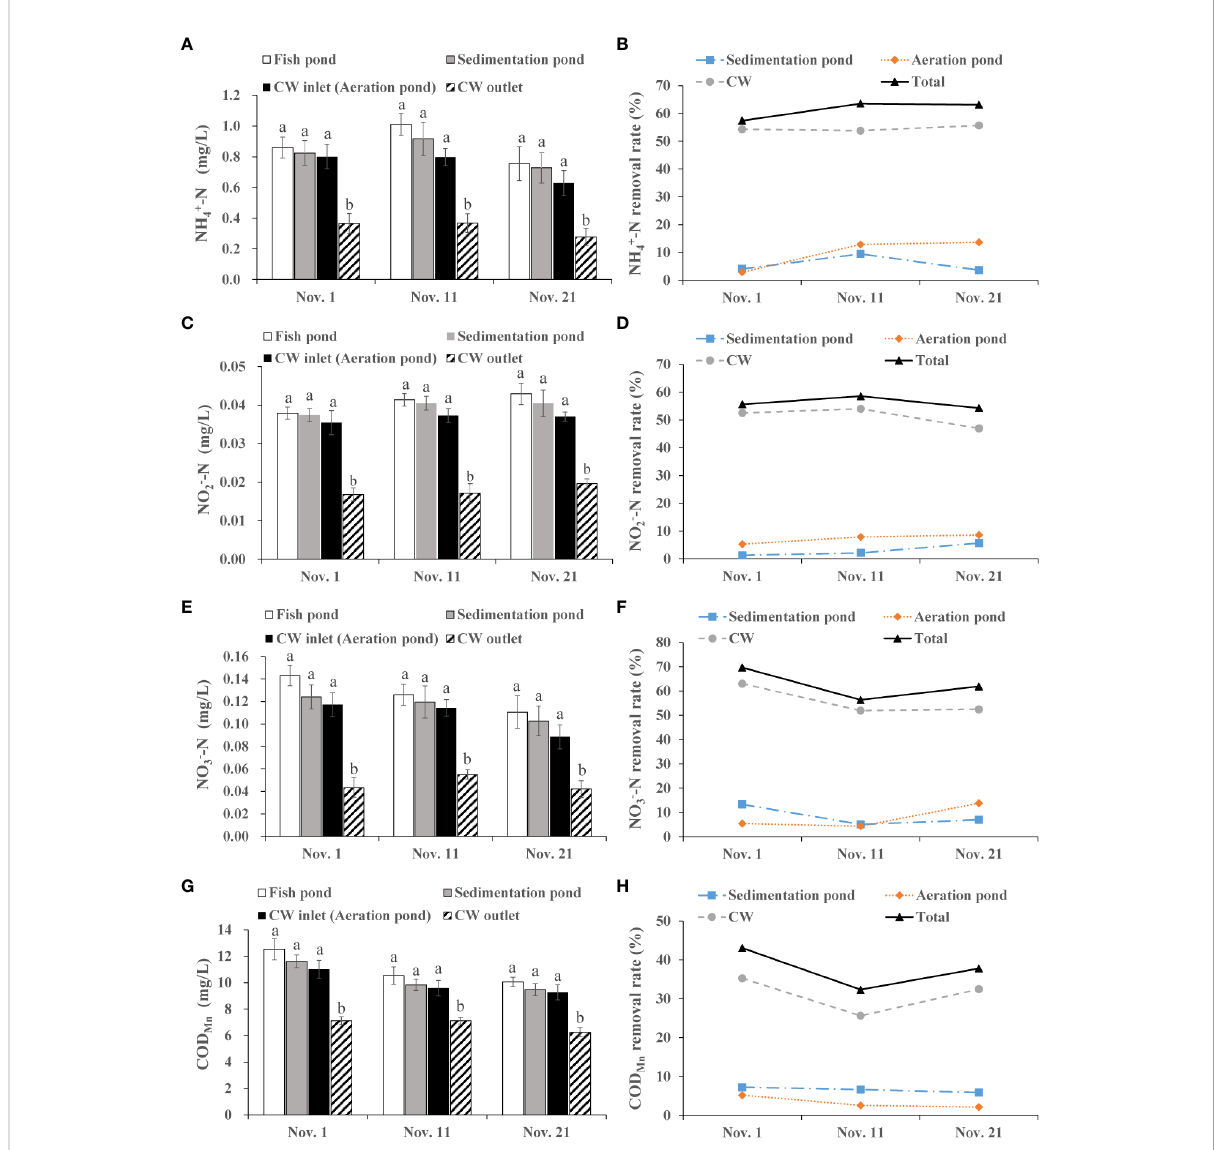
FIGURE 4 Removal ef fi ciency of integrated CW system on NH 4+ -N, NO 3- N, NO 2- -N and COD Mn during the ef fl uents discharge period. (A) NH 4+ -N value in the fi sh pond, sedimentation pond, CW inlet (aeration pond) and CW outlet. (B) NH 4+ -N removal rate of the sedimentation pond, aeration pond and CW. (C) NO 2- -N value in the fi sh pond, sedimentation pond, CW inlet (aeration pond) and CW outlet. (D) NO 2- -N removal rate of the sedimentation pond, aeration pond and CW. (E) NO 3- -N value in the fi sh pond, sedimentation pond, CW inlet (aeration pond) and CW outlet. (F) NO 3- -N removal rate of the sedimentation pond, aeration pond and CW. (G) COD Mn value in the fi sh pond, sedimentation pond, CW inlet (aeration pond) and CW out. (H) COD Mn removal rate of the sedimentation pond, aeration pond and CW. The value is expressed as mean ± SE (n = 5). Different small letters in bar graph indicate signi fi cant difference (p< 0.05) among fi sh pond, sedimentation pond, CW inlet (aeration pond) and CW